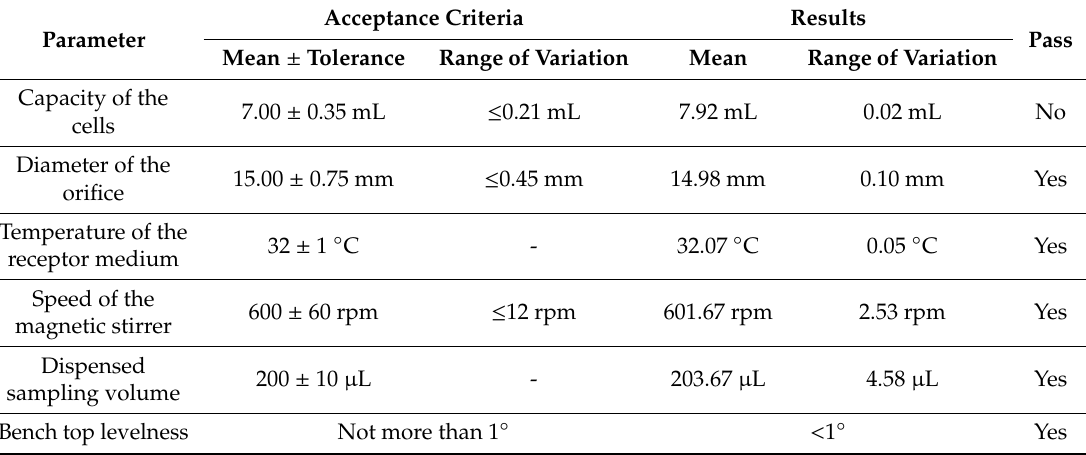
Table 2. Predefined acceptance criteria and the results obtained from apparatus qualification for the VDC